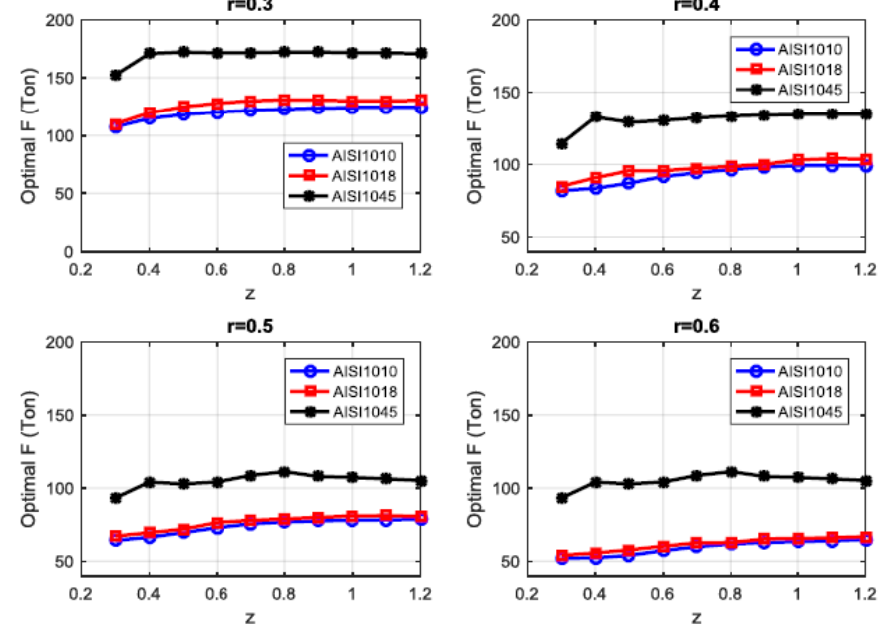
Figure 17. Comparison of optimal values of punch force of different steels.